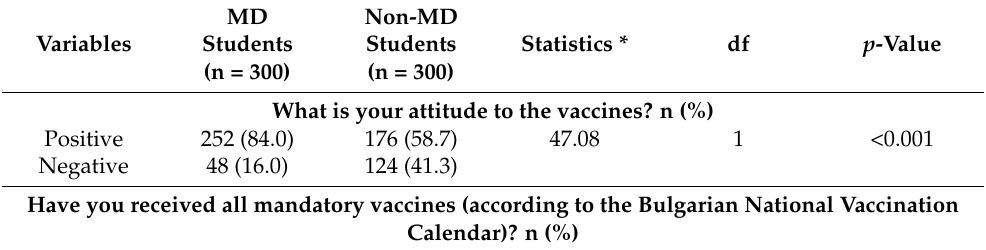
Table 2. Comparison of students’ questionnaire answers for vaccination process and all manda- tory